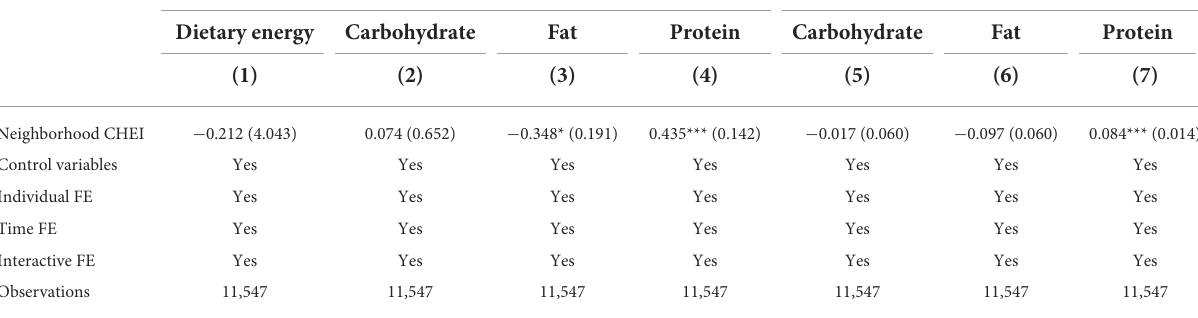
TABLE 4 Estimation of neighborhood effects on nutrient intakes of older adults (fixed effects